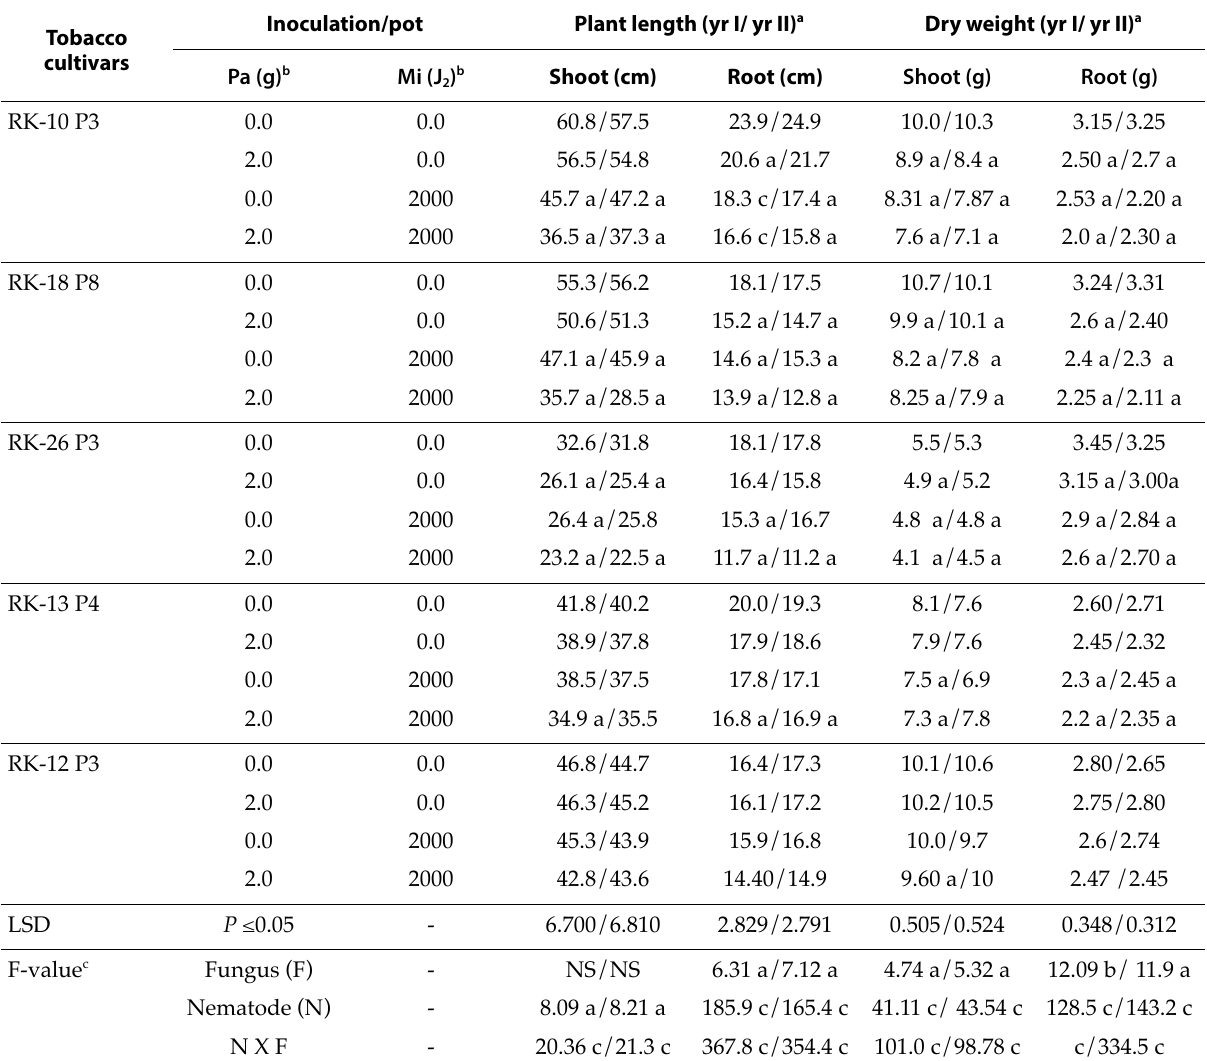
Table 2. Mean plant parameters for different tobacco cultivars inoculated with Pythium aphanidermatum or Meloidogyne incognita as single or concomitant inoculations. Tobacco